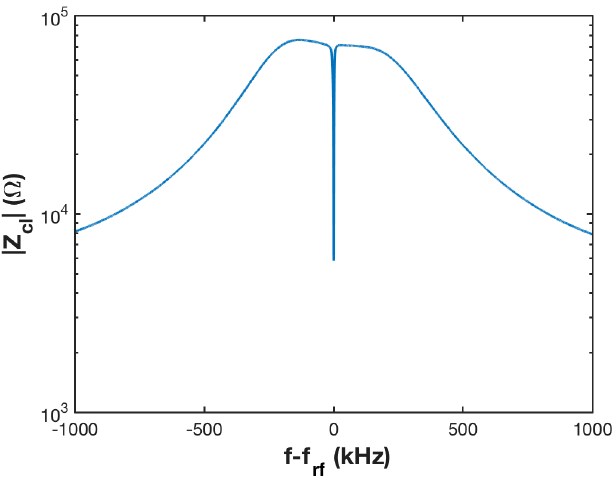
FIG. 11. Z phase for detuning of zero and − 8 . 2 kHz. Physics cl settings: Q L ¼ 60000 , V c ¼ 2 MV. Rf station optimized with zero